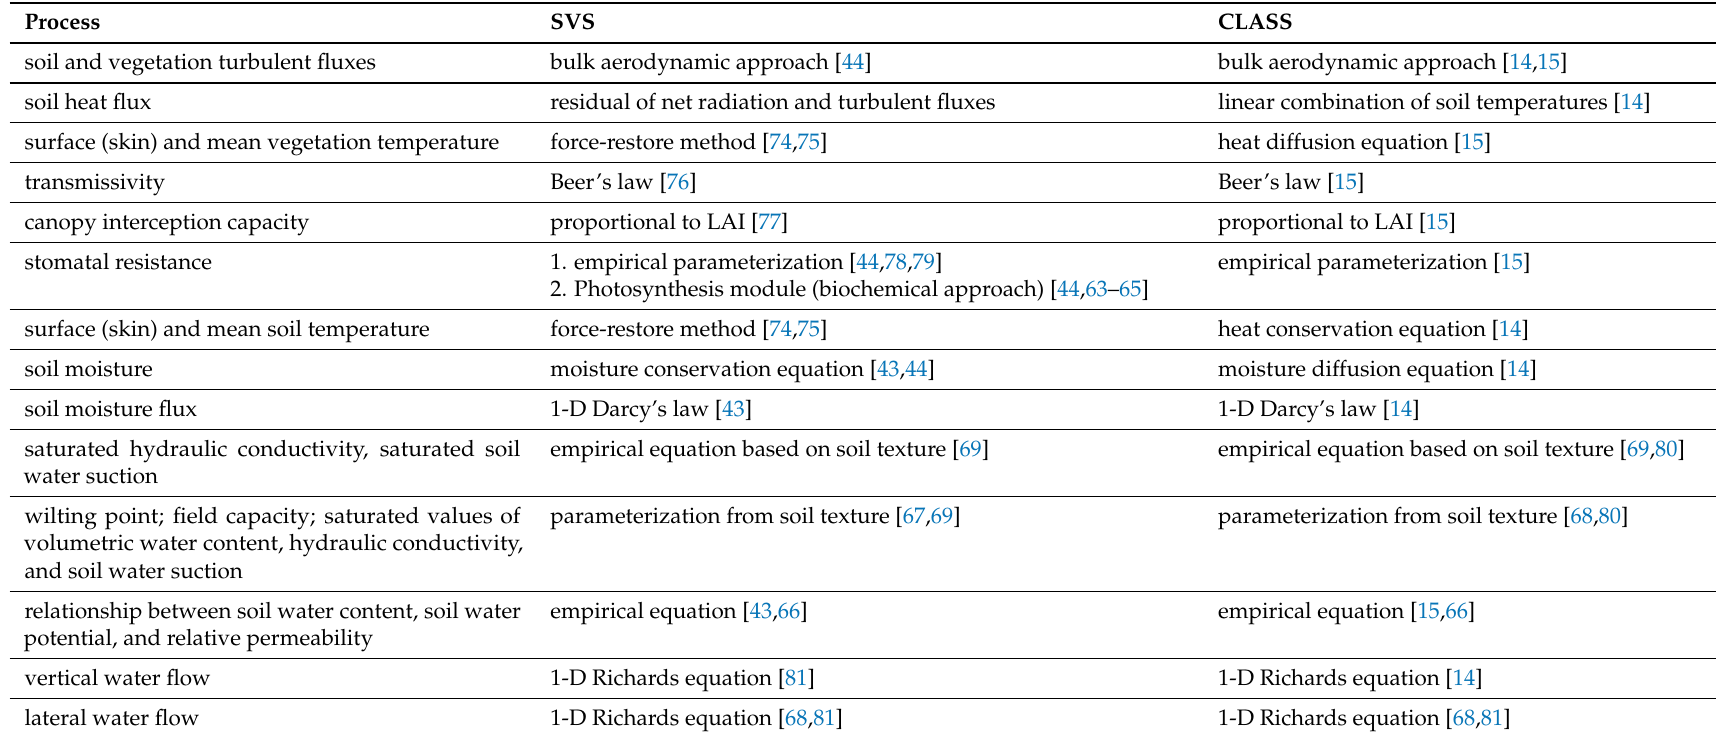
Table 2. Summary of SVS and CLASS main physical